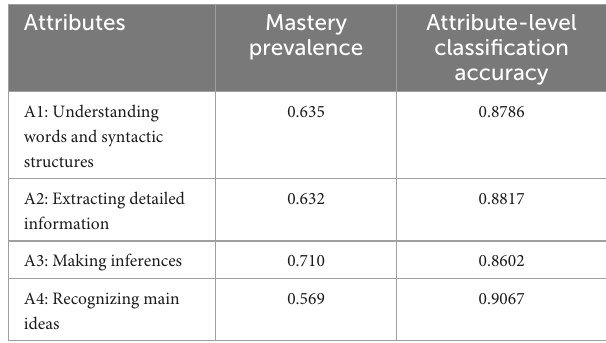
TABLE 5 Attribute prevalence and classification